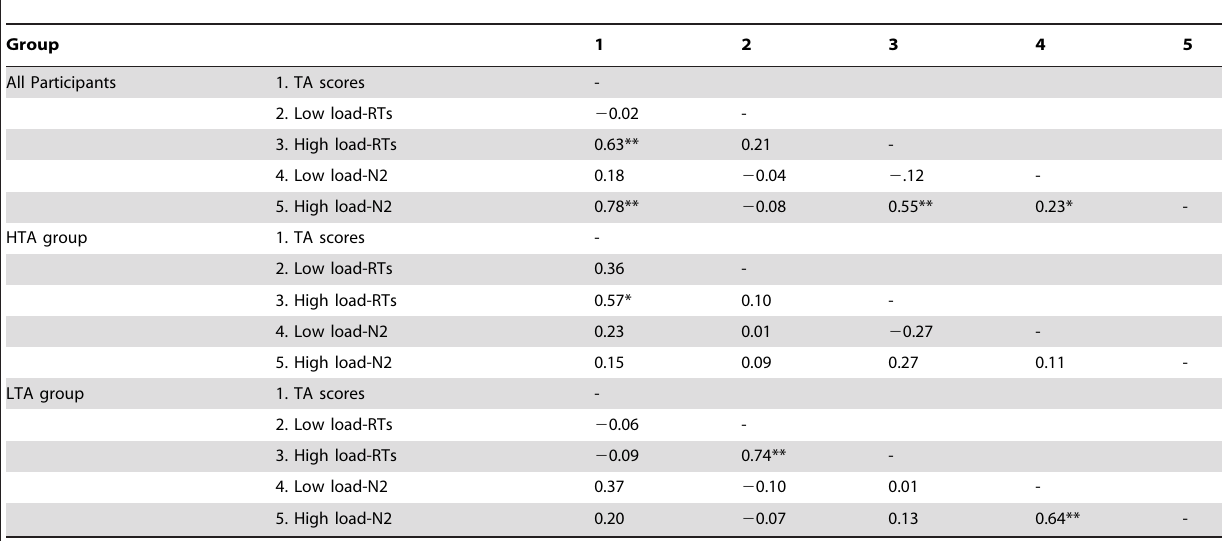
Table 4. Correlations between trait anxiety (TA) scores and indices of interference effects (i.e., incongruent-congruent) on reaction responses (RTs) and N2 amplitudes under low or high WM